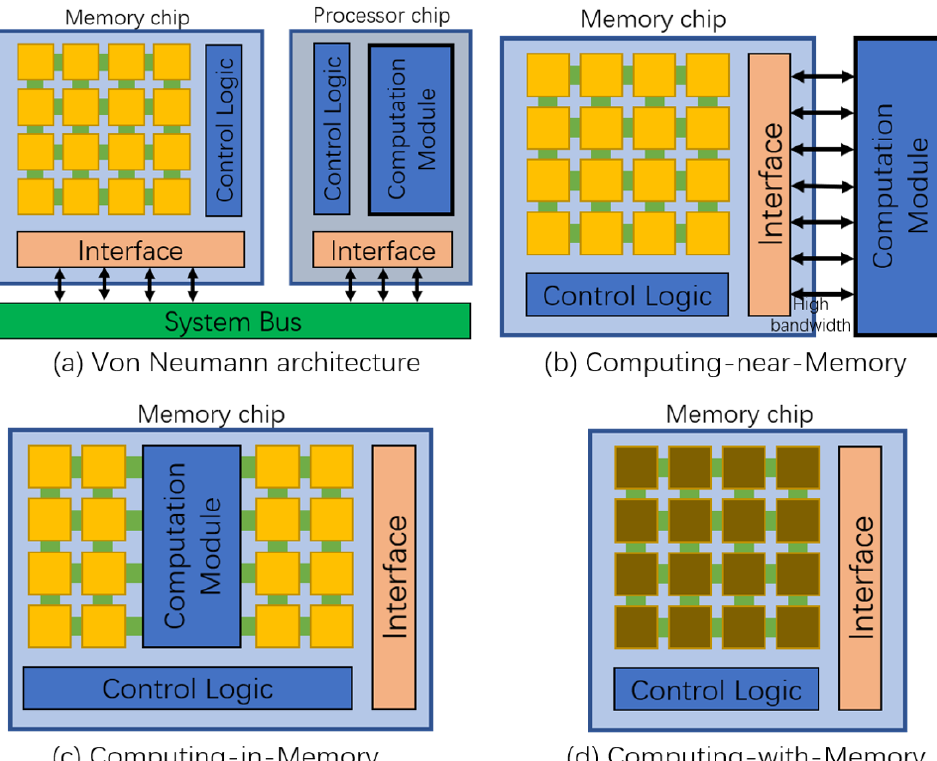
Figure 4. Comparison of Von Neumann architecture and three technology roadmaps for Memory- Centric Computing